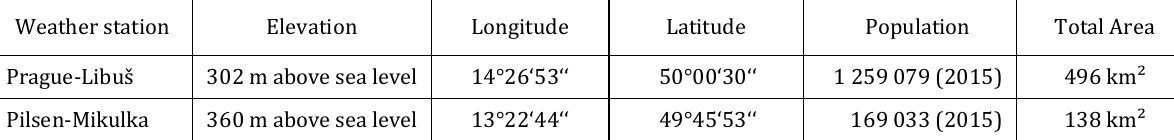
Fig. 2. Location of the two stations compared, Prague-Libuš and Pilsen-Mikulka (source: CHMI) Table 1. Basic information about the location of the two compared stations in Prague-Libuš and